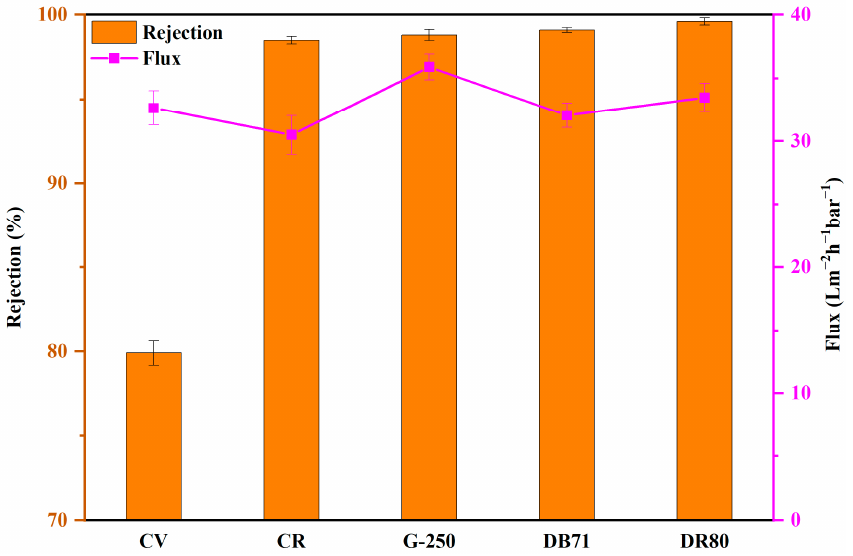
Figure 12. The rejection of PES–DPS–1 for various dyes (the concentration was 0.2 g·L − 1 ).